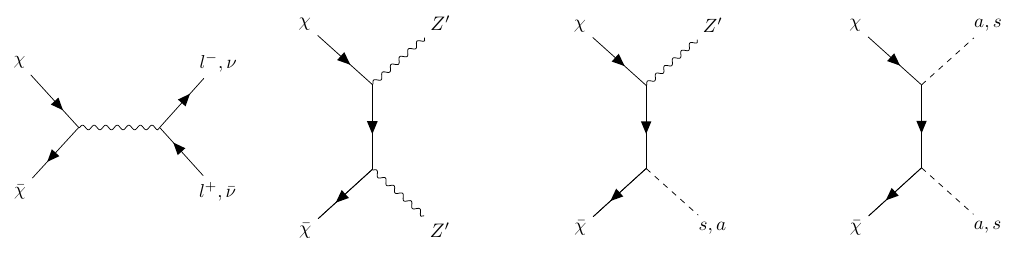
Figure 2. Tree-level annihilations of the dark fermion χ